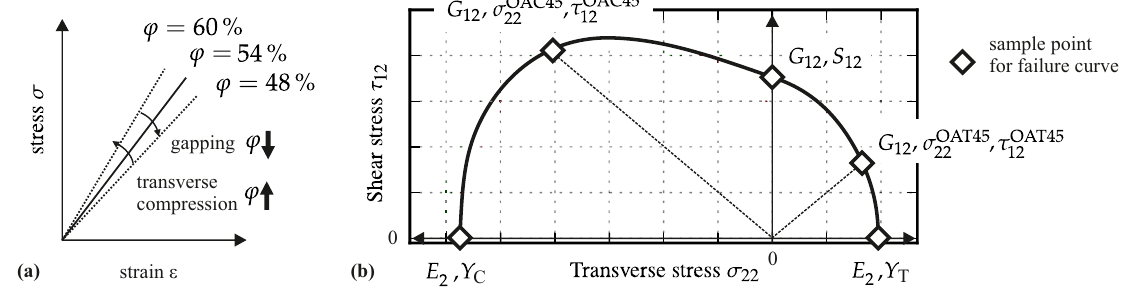
Figure 3. Schematic illustration of the influence of draping effects on mechanical properties ( a ) and visualization of parameters for obtaining sample points for failure curves ( b ).